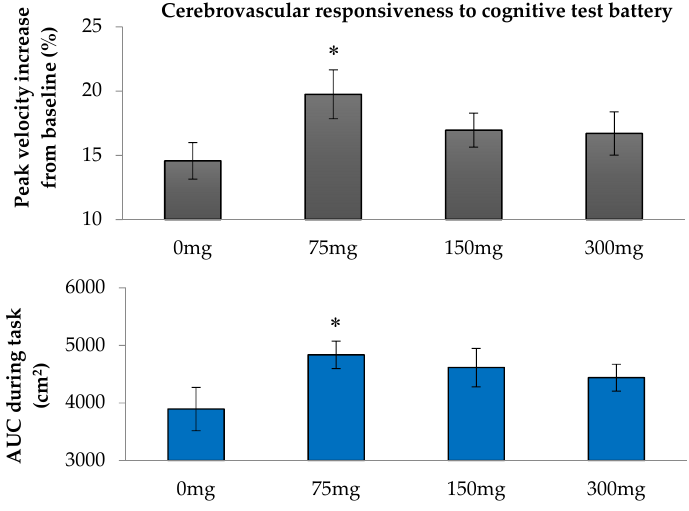
Figure 1. Overall cerebrovascular responsiveness to dual and multi-tasking test batteries for placebo and three resveratrol doses: ( Top ) the percentage increase in mean blood flow velocity (BFV) from basal velocity; and ( bottom ) area under the curve (AUC) of the BFV responses to tests. Data are mean ± SEM. * P < 0.038 compared to placebo.